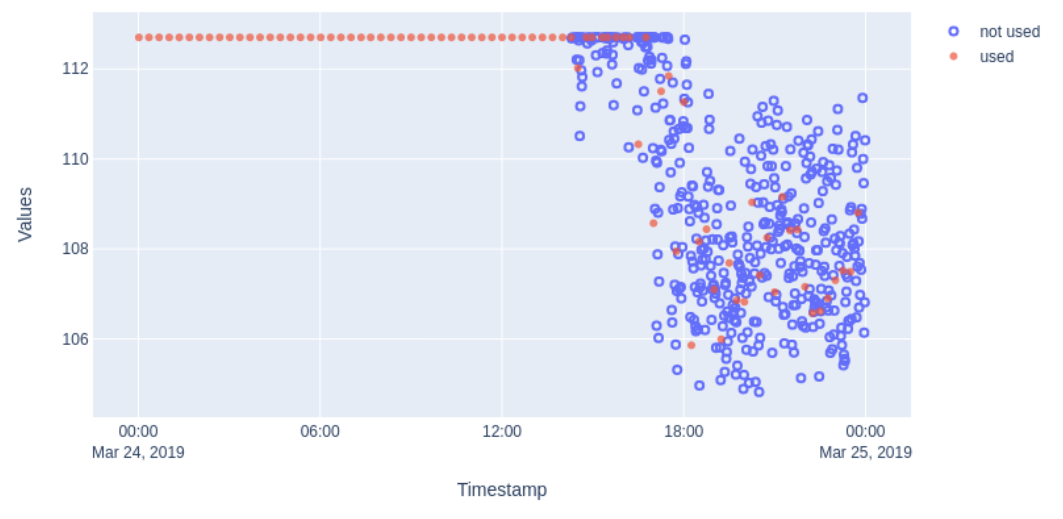
Figure 14. Data used and not used from y to generate ˆ y